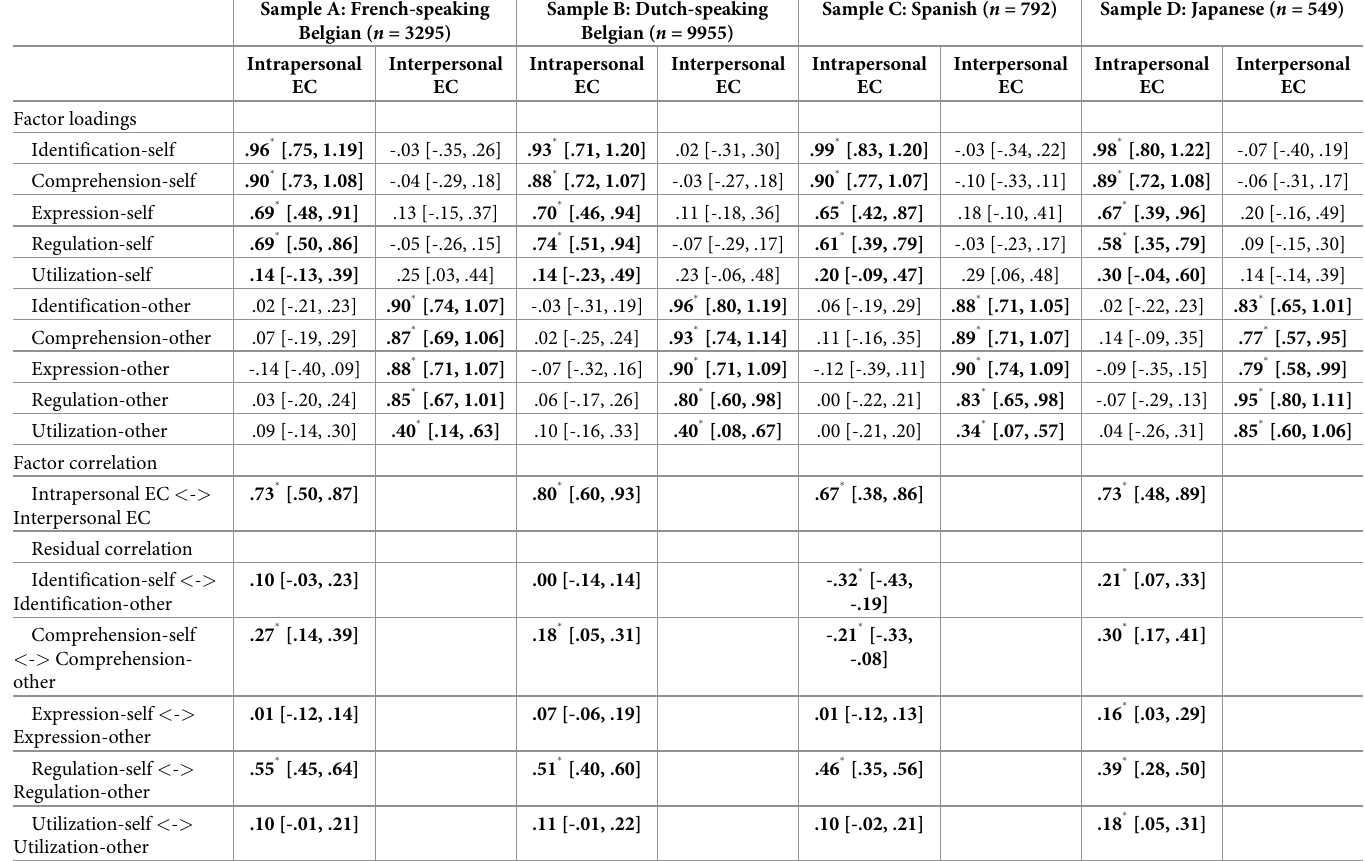
Table 4. Results of Bayesian structural equation modeling of the modified target-based structure model ( d = 200). Sample A: French-speaking Belgian ( n = 3295)